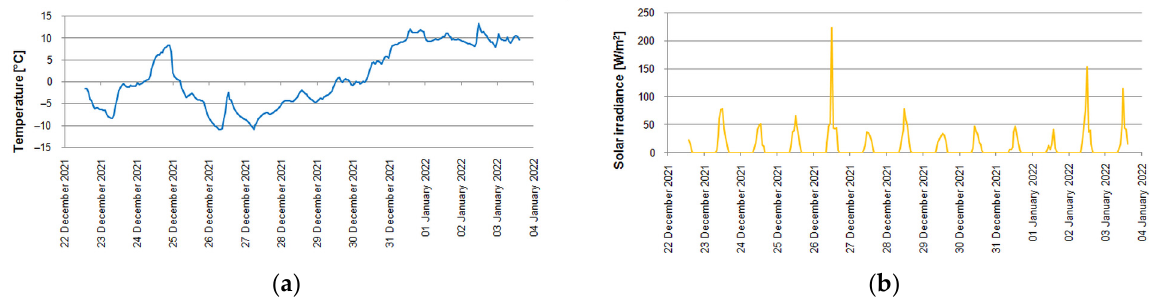
Figure 4. Meteorological conditions during the experiment: ( a ) External air temperature; ( b ) Global solar irradiance on the external wall.